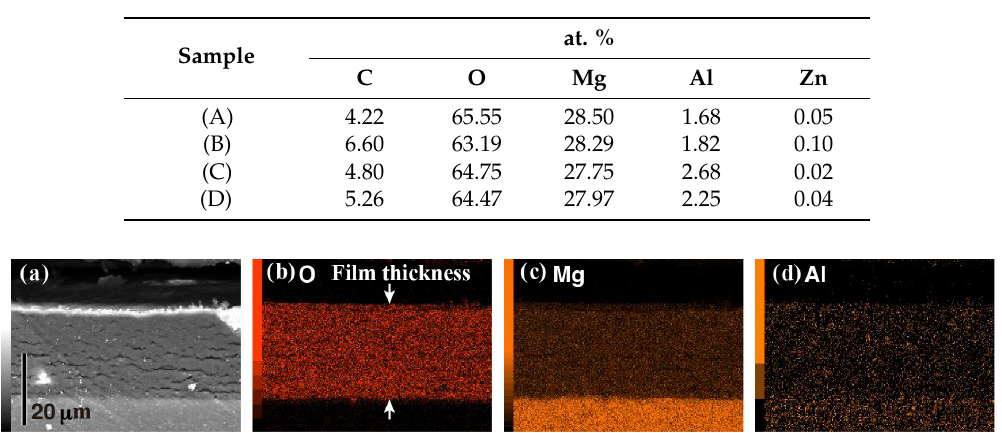
Figure 4. Cross-sectional image ( a ) and elemental mappings of the cross-sections ( b ), ( c ), ( d ) for Mg, Al, and O of the sample (C) treated at 0.42